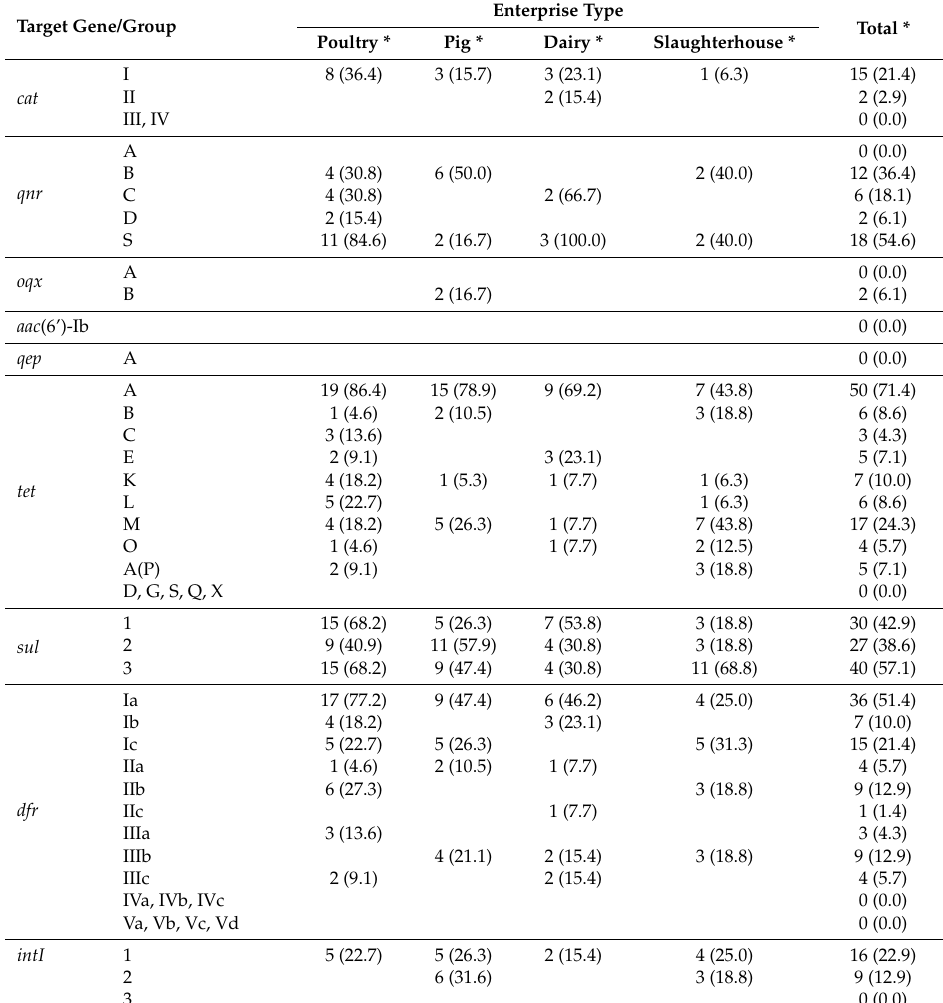
Table 3. Absolute and relative frequency of isolates with cat , qnr , oqx , aac (6’)-Ib, qep , tet , sul , dfr and intI genes per enterprise